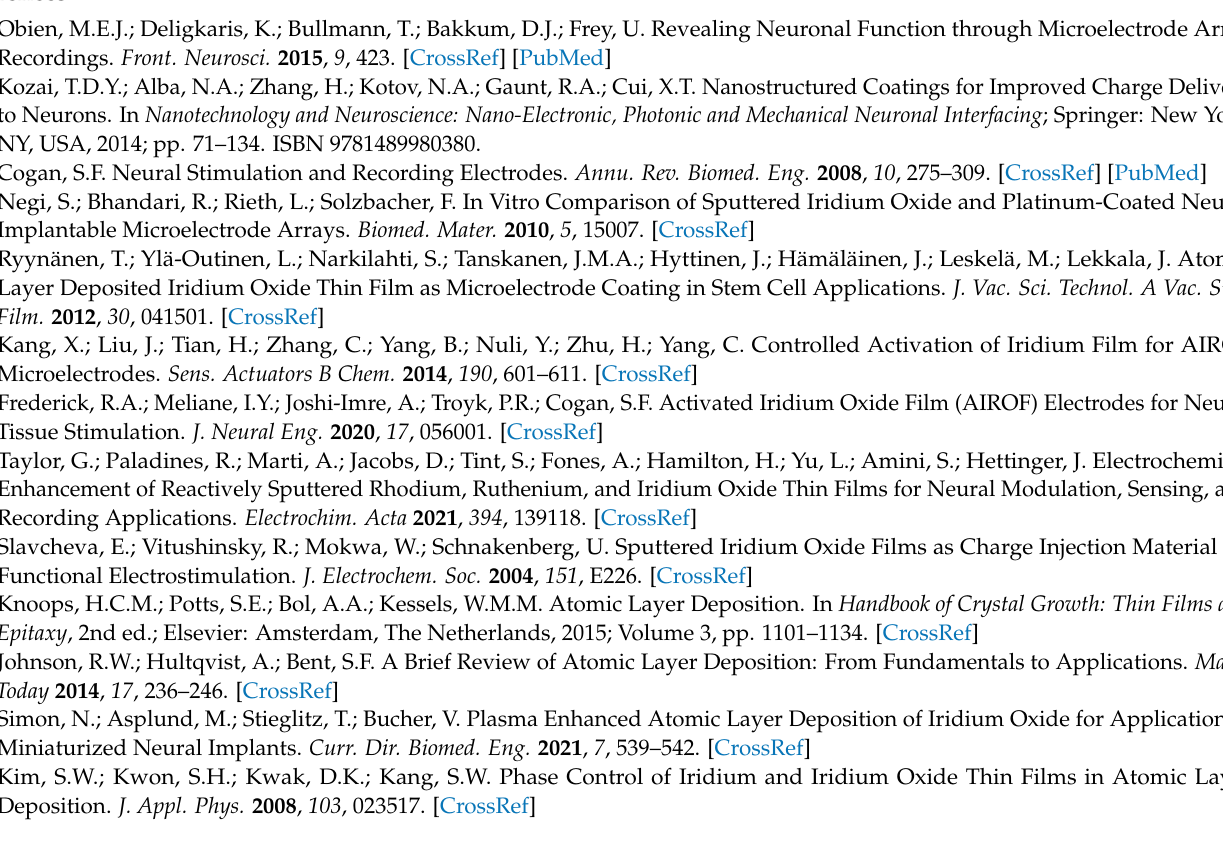
ness; Equation (S2): height–height correlation function; Equation (S3): gaussian fitting function; Figure S1: AFM of PtSi with the related height–height correlation function; Figure S2: power spectral density function (PSDF) spectra of all the AFM data on IrO 2 and PtSi; Figure S3: AFM measurement of IrO 2 deposited by PA-ALD onto Al 2 O 3 (20 nm) on c-Si; Equation (S4): definition of the CPE impedance; Table S1: parameters of the equivalent circuit obtained from the modeling of the EIS data; Figure S4: plot of the capacitive current vs. scan rate obtained from CV